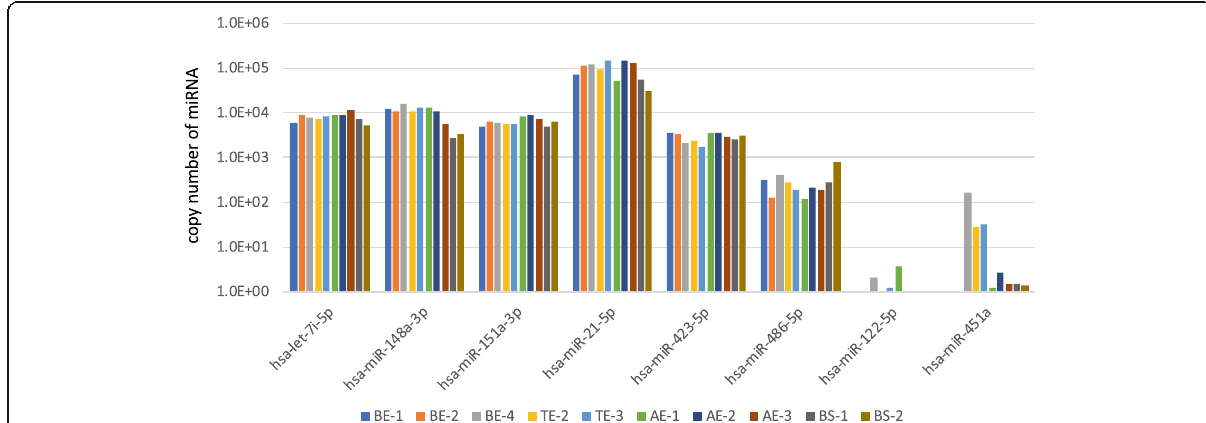
Fig. 3 miRNA expression levels in airway epithelial cells in next-generation sequencing. The figure shows the expression numbers of the eight miRNAs used in the diagnosis of active TB and LTBI in bronchial epithelium (BE), tracheal epithelium (TE), alveolar epithelium (AE), and bronchial smooth muscle (BS) cells. The miRNA expression profiles of the BE (BE-1, BE-2, and BE-4), TE (TE-2, TE-3), AE (AE-1, AE-2, and AE-3), and BS (BS-1, BS-2) cells were obtained from three, two, three, and two healthy volunteers,